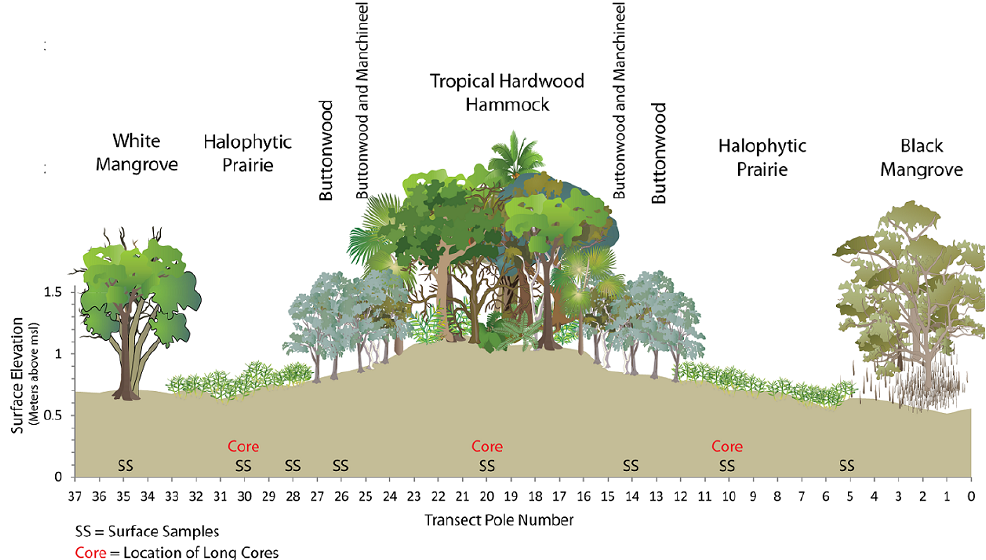
Figure 3. West-to-east transect of about 370 m across the Coot Bay Hammock showing the sharp gradations between vegetation types. Transect poles mark 10 m distances, and locations where surface samples and core samples were taken. Figure courtesy of Brandon Gamble, National Park Service. Graphic symbols courtesy of the Integration and Application Network, University of Maryland Center for Environmental